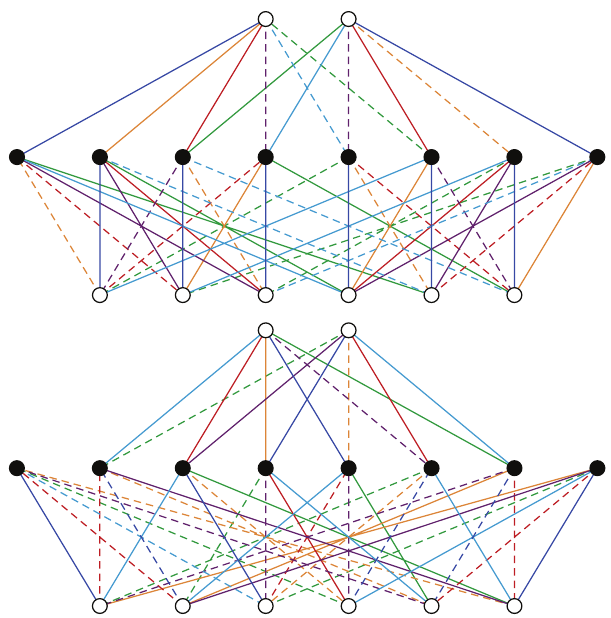
Figure 8: Two nonisomorphic height 3, (6, 2) Adinkras belonging to the same equivalence